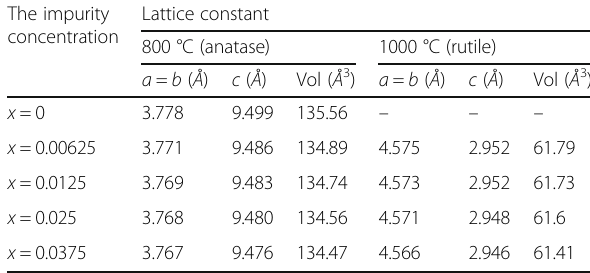
Table 1 Variation in the lattice constant with Cr concentrations